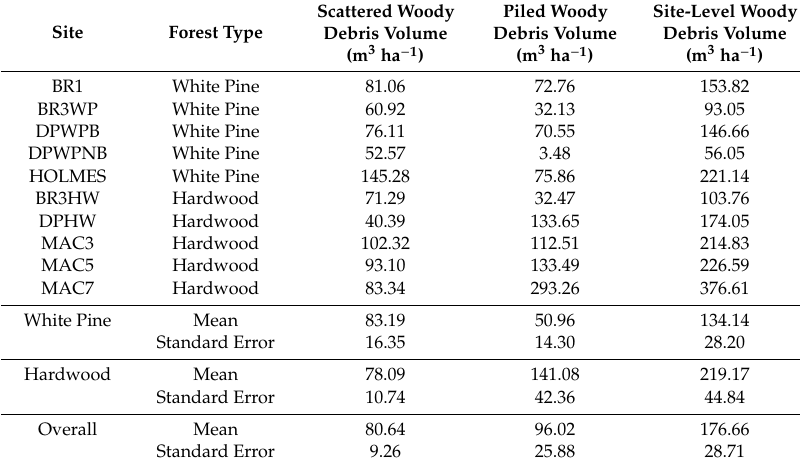
Table 2. Scattered, piled, and site-level woody debris volumes at each of 10 harvest sites in western North Carolina based on measurements taken winter 2016–2017. We classified each site as white pine or hardwood based on the overstory trees present before